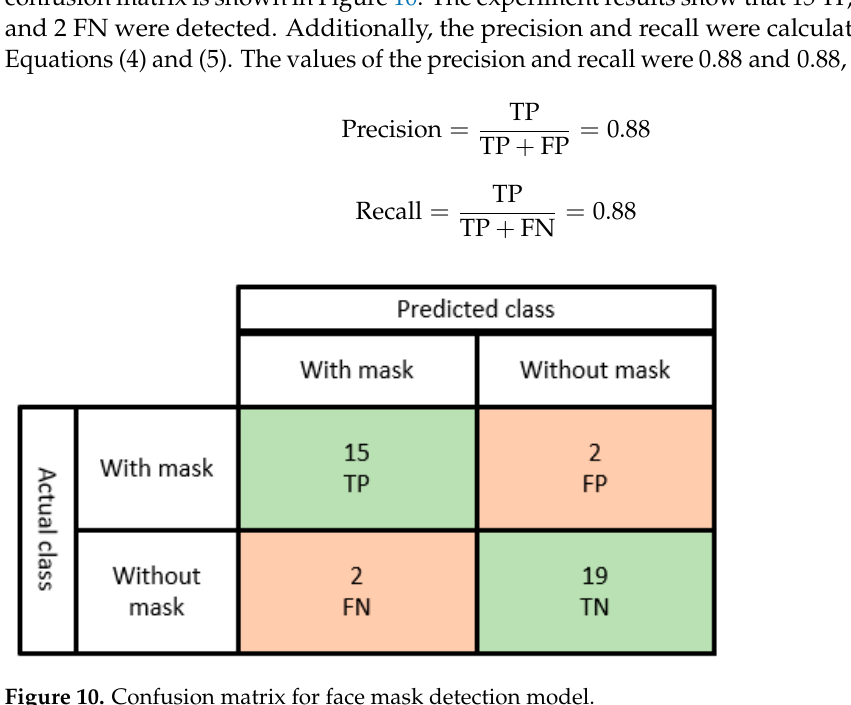
Figure 10. Confusion matrix for face mask detection model.